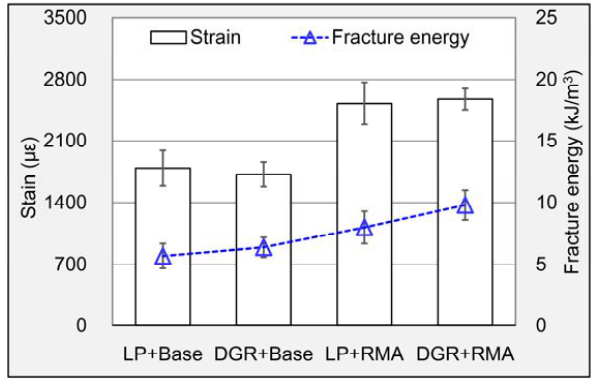
Figure 16. Strain and fracture energy of different asphalt mixtures.